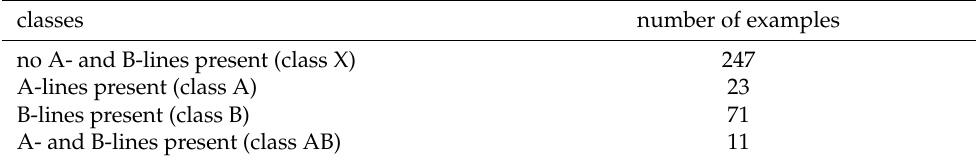
Table 2. POCUS dataset overview.